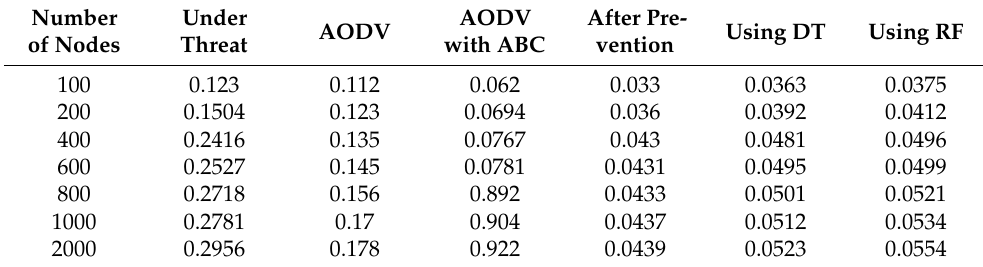
Table 6. Average Delay(s).